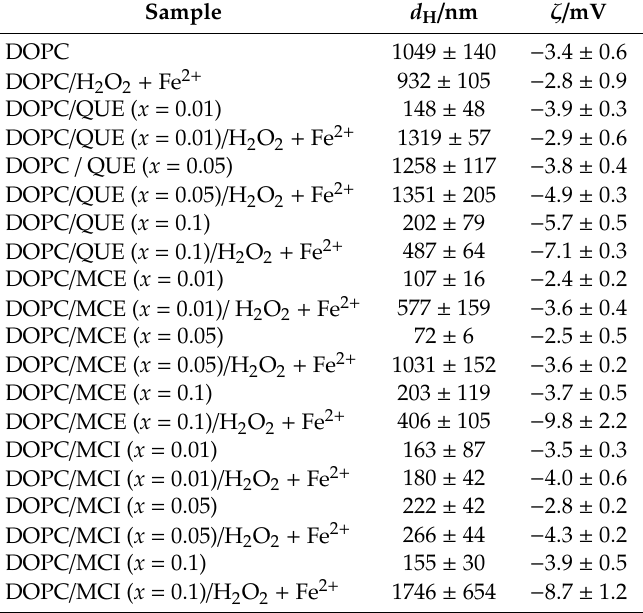
Table 1. Changes in the average hydrodynamic diameter ( d H ) and zeta potential ( ζ ) of liposomes during the insertion of flavonols and induced lipid